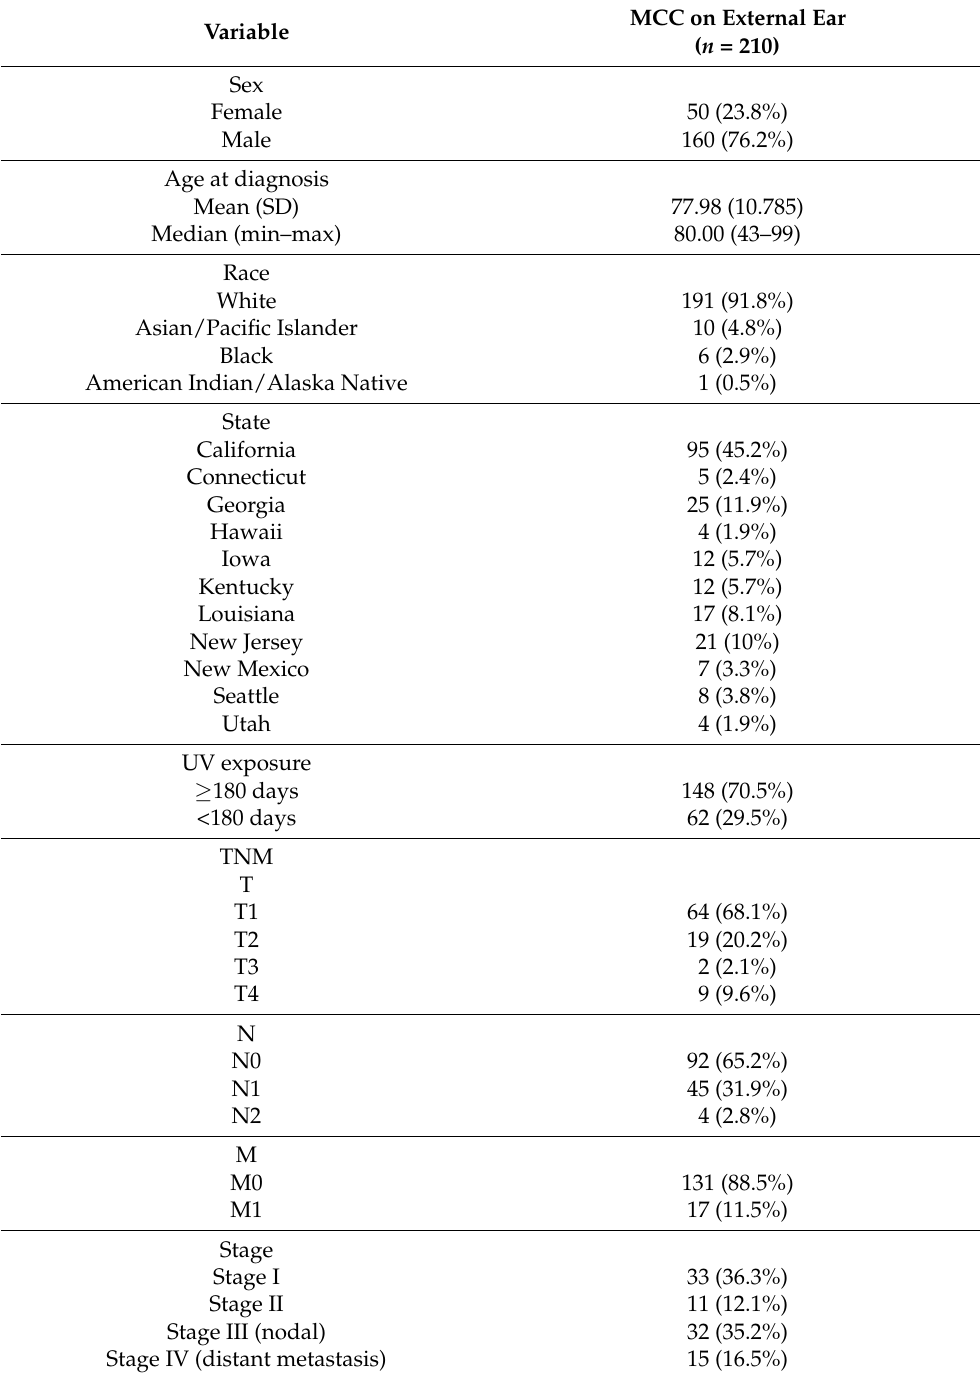
Table 1. Demographic and pathological characteristics of the study